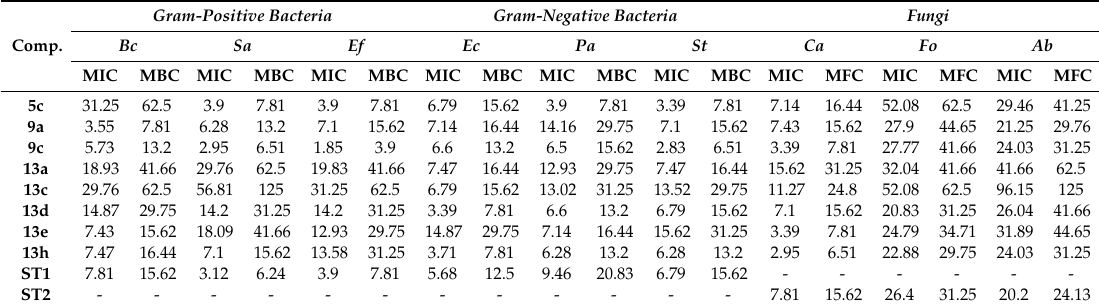
Gram-positive bacteria: Bacillus cereus (ATCC14579, Bc), Staphylococcus aureus (ATCC 29213, Sa) and Enterococcus faecalis (ATCC 29212, Ef). Gram-negative bacteria: Escherichia coli (ATCC 25922, Ec), Pseudomonas aeruginosa (ATCC 27853, Pa) and Salmonella typhi (ATCC 6539, St). Fungi: Candida albicans (ATCC 10231, Ca), Fusarium oxysporum (RCMB 008002, Fo) and Aspergillus brasiliensis (ATCC 16404, Ab). ST1: Amoxicillin / Clavulanic acid as antibacterial standard; ST2: Nystatin as antifungal